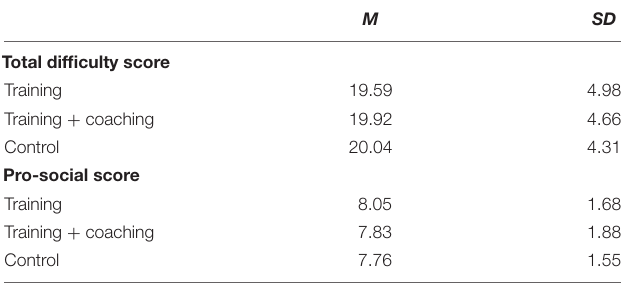
TABLE 1 | Means and standard deviations for the subsample students ( N = 211). M